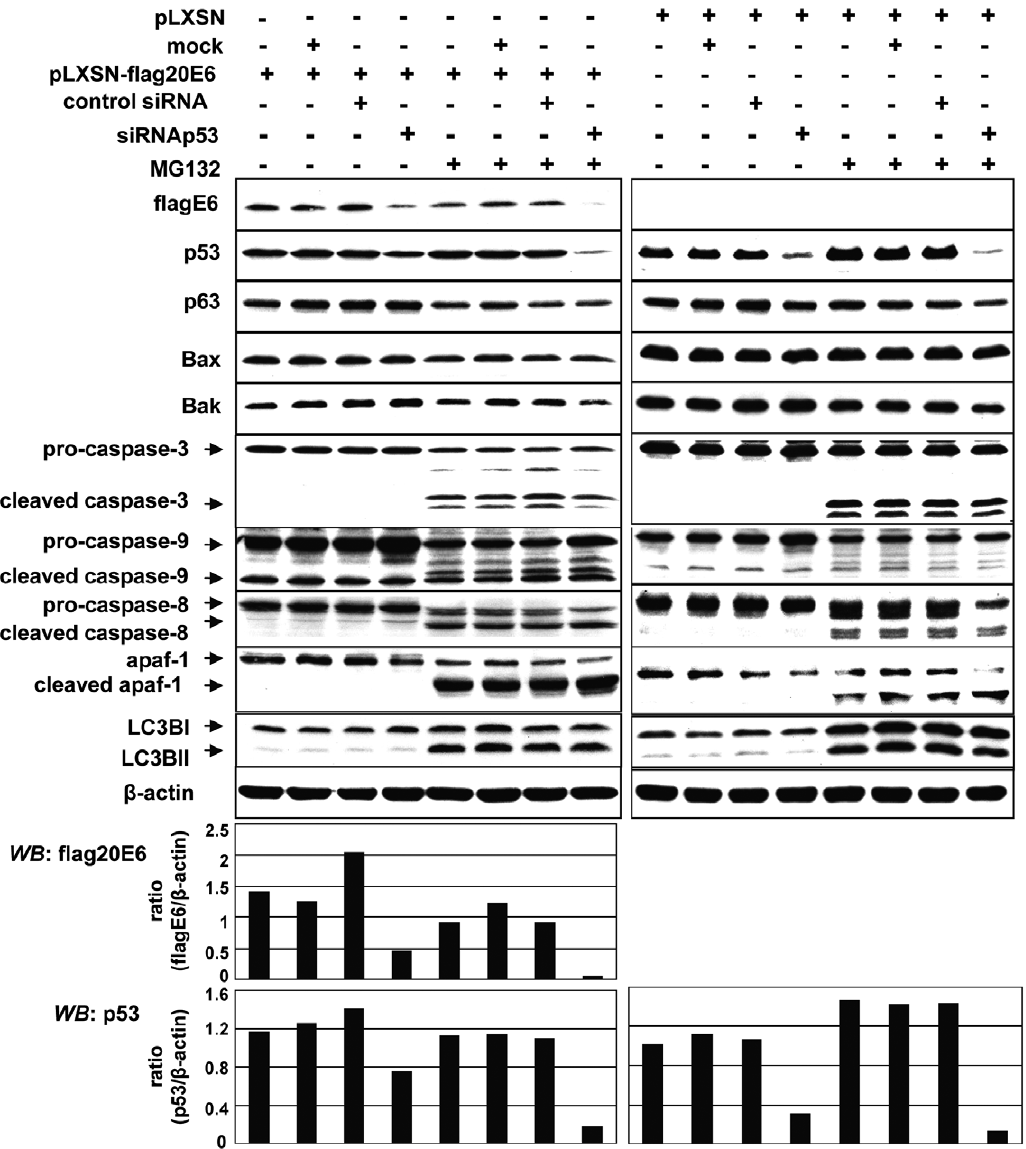
Figure 4. Down-regulation of HPV20E6 is influenced by proteins other than those involved in apoptosis or autophagy. Western blot analysis of cell lysates from pLXSN-flagHPV20E6- and pLXSN-NIKS cells after transfection with siRNAp53 (10 nM) or siRNA-NK (negative control siRNA, 10 nM) and incubation for 16 h with or without MG132 (10 m m). MG132 treatment induced activation of apaf-1, caspase-8, caspase-9 and caspase-3, as well as the autophagy marker LC3BII. Histograms represent HPV20E6 and wtp53 protein levels normalized against b